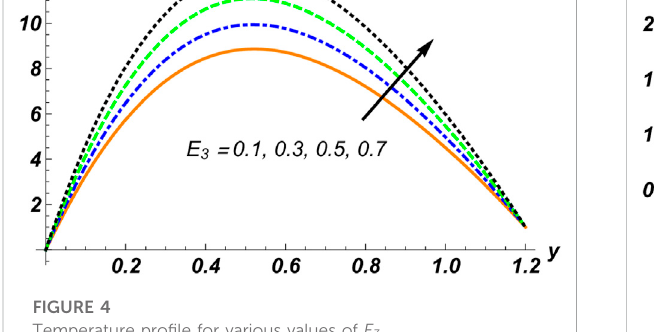
Temperature pro fi le for various values of E 3 .